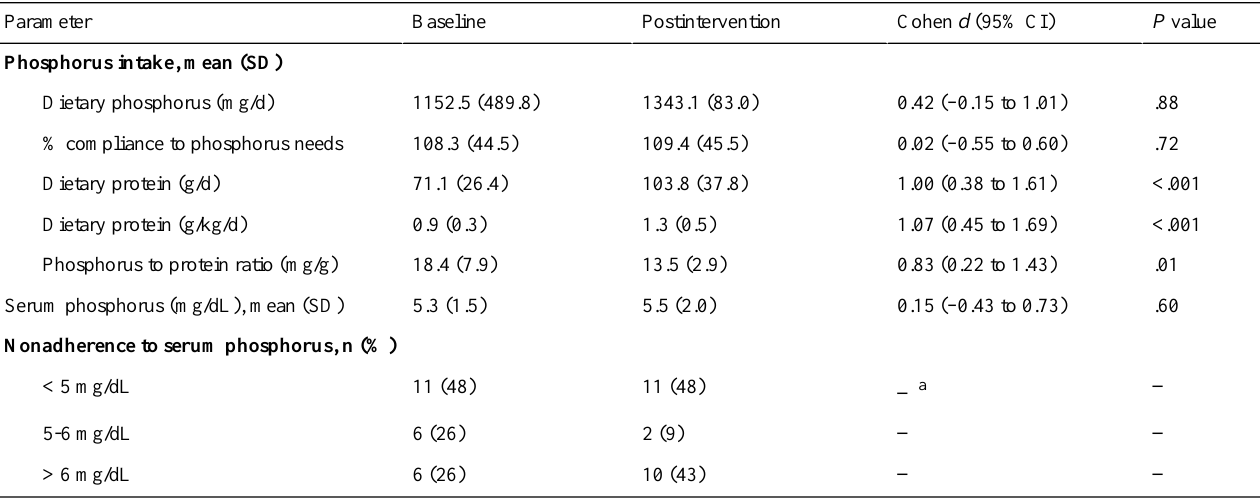
Table 3. Baseline and postintervention dietary intake and serum phosphorus level